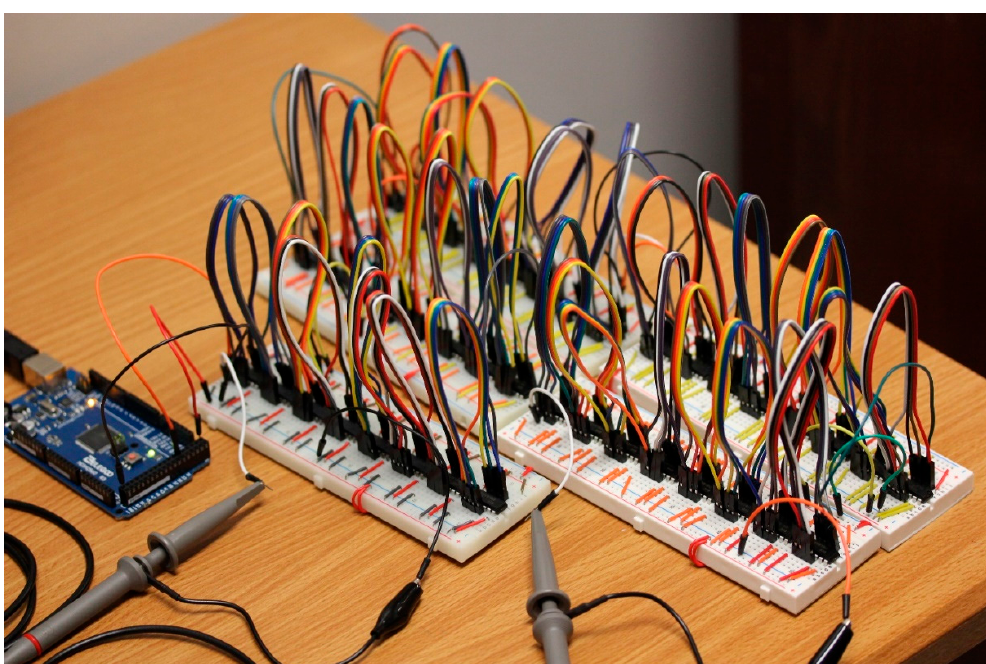
Figure A1. Hardware network implementation—top view.